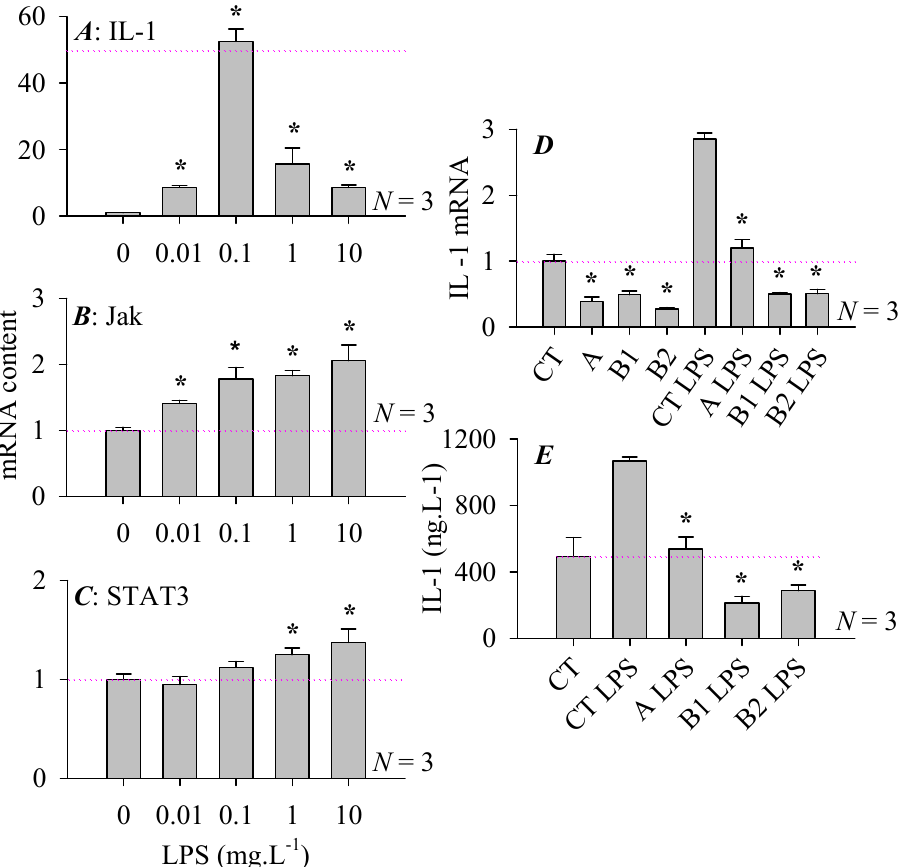
Figure 4. Msr over-expression inhibited LPS-stimulated IL-1 production. Cultured rat pancreatic stellate cells were stimulated with LPS (0, 0.01, 0.1, 1, 10 mg.L − 1 ) for 24 h. IL-1, JAK, STAT3 mRNA content was detected by real-time quantitative PCR ( A - C ). At 24 h after adenovirus-mediated over-expression of MsrA, B1 or B2, rat pancreatic stellate cells were stimulated with LPS (1 mg.L − 1 ) for 24 h, IL-1 expression was then measured by real-time PCR for mRNA content ( D ) or by ELISA for protein content in medium ( E ). CT: control cells with empty vector. A, B1, B2: MsrA, MsrB1, MsrB2 over-expressing cells respectively. CT: empty vector cells. CT LPS: empty vector cells stimulated with LPS. A LPS, B1 LPS, B2 LPS: MsrA, MsrB1, MsrB2 over-expressing cells stimulated with LPS respectively, all at 1 mg.L − 1 . The pink thin dashed horizontal line in ( A ) indicates mRNA level of 50, in ( B , C , D ) the mRNA level of 1.00 and in ( E ) IL-1 content from control cells (CT, empty vector). Asterisks (*) indicate statistical significance when compared with LPS concentration of 0 in ( A - C ), when compared with CT or CT LPS respectively in ( D ), when compared with CT LPS in ( E ), all at p < 0.05, N = 3.